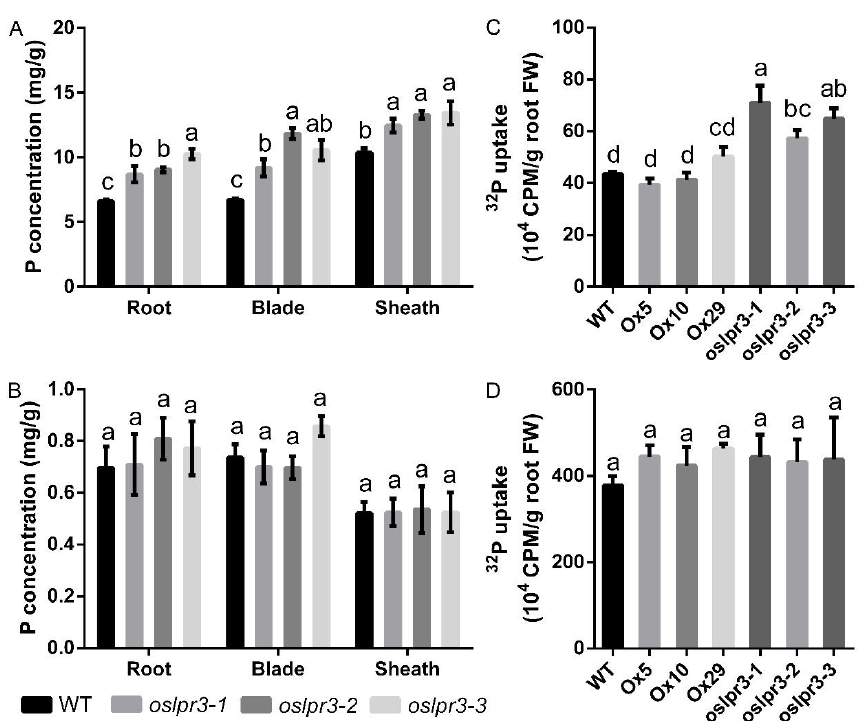
Figure 7. Total P concentration in oslpr3 lines. ( A , B ) Seedlings (10-d-old) of WT and oslpr3 lines were grown hydroponically under +P (A) and − P (B) conditions for 21 d. The total P concentration was determined in roots, leaf blades, and leaf sheaths. Values are means ± SE ( n = 5). ( C , D ) Seedlings (10- d-old) of WT, OsLPR3-Ox, and oslpr3 lines were grown hydroponically under +P (C) and − P (D)